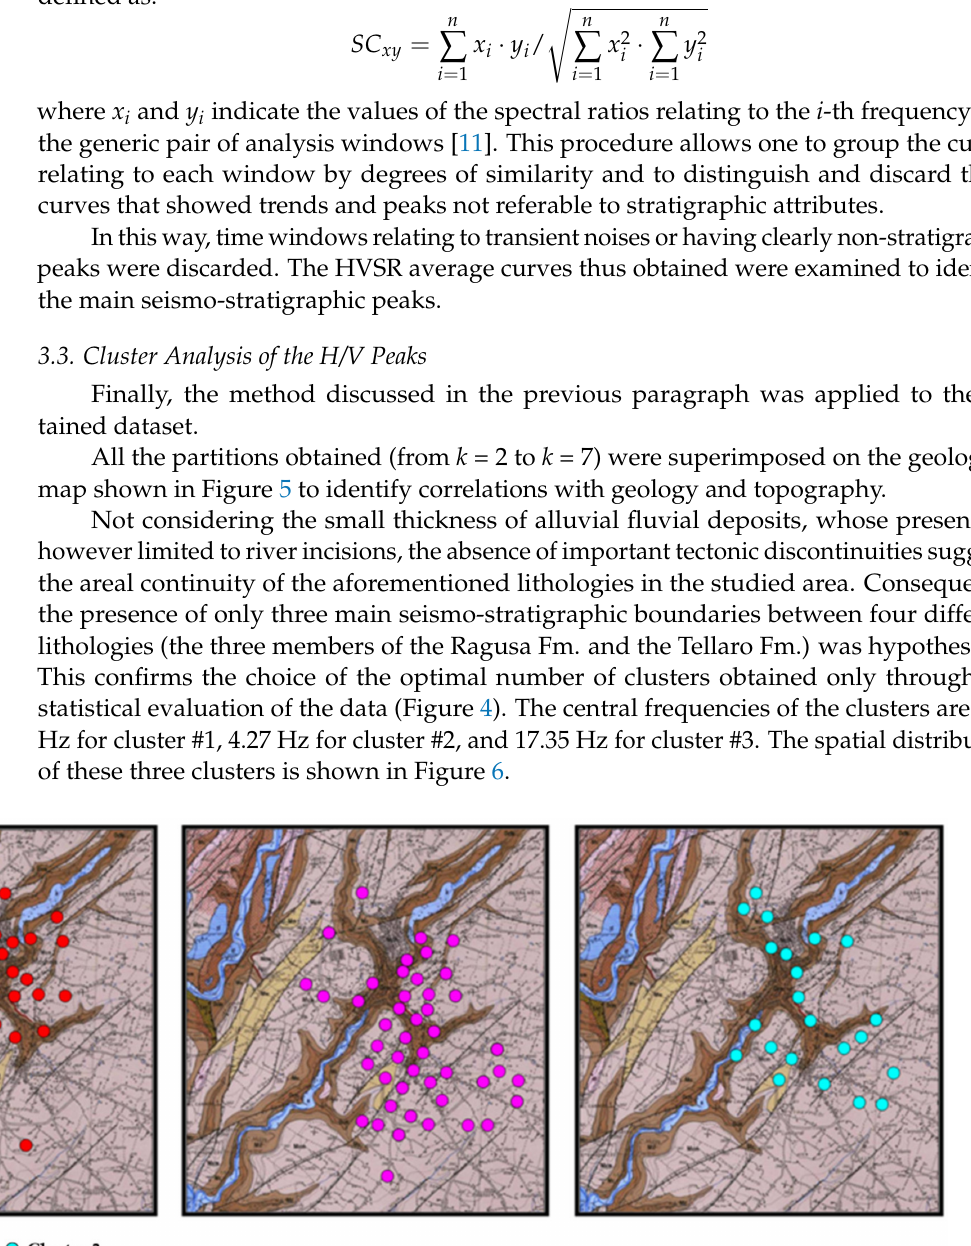
Figure 6. Spatial distribution of the H/V peaks for each of the three clusters obtained from the dataset of the city of